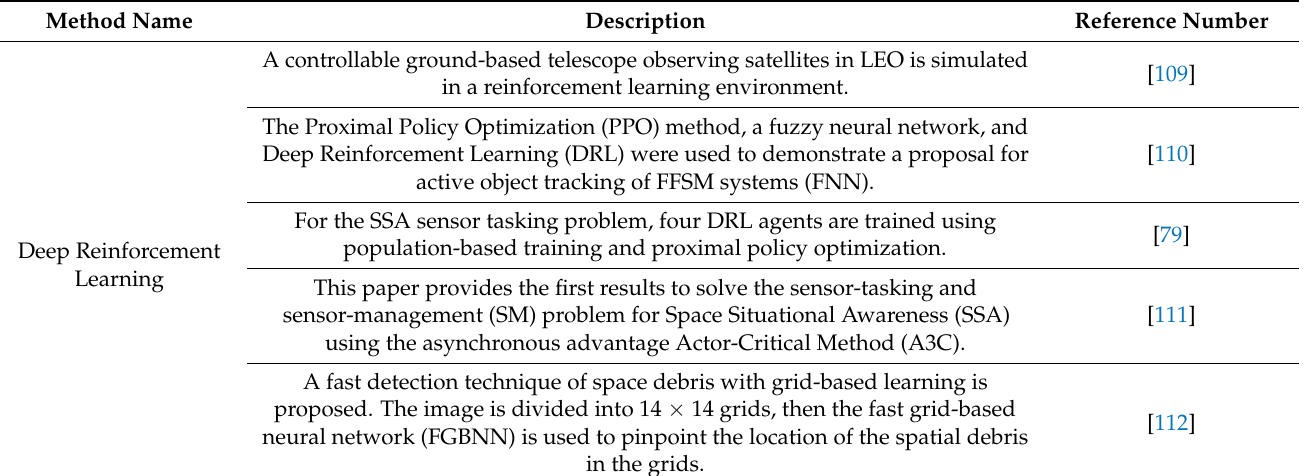
Table 3. Reinforcement Learning-based methods for SSA space debris detection.